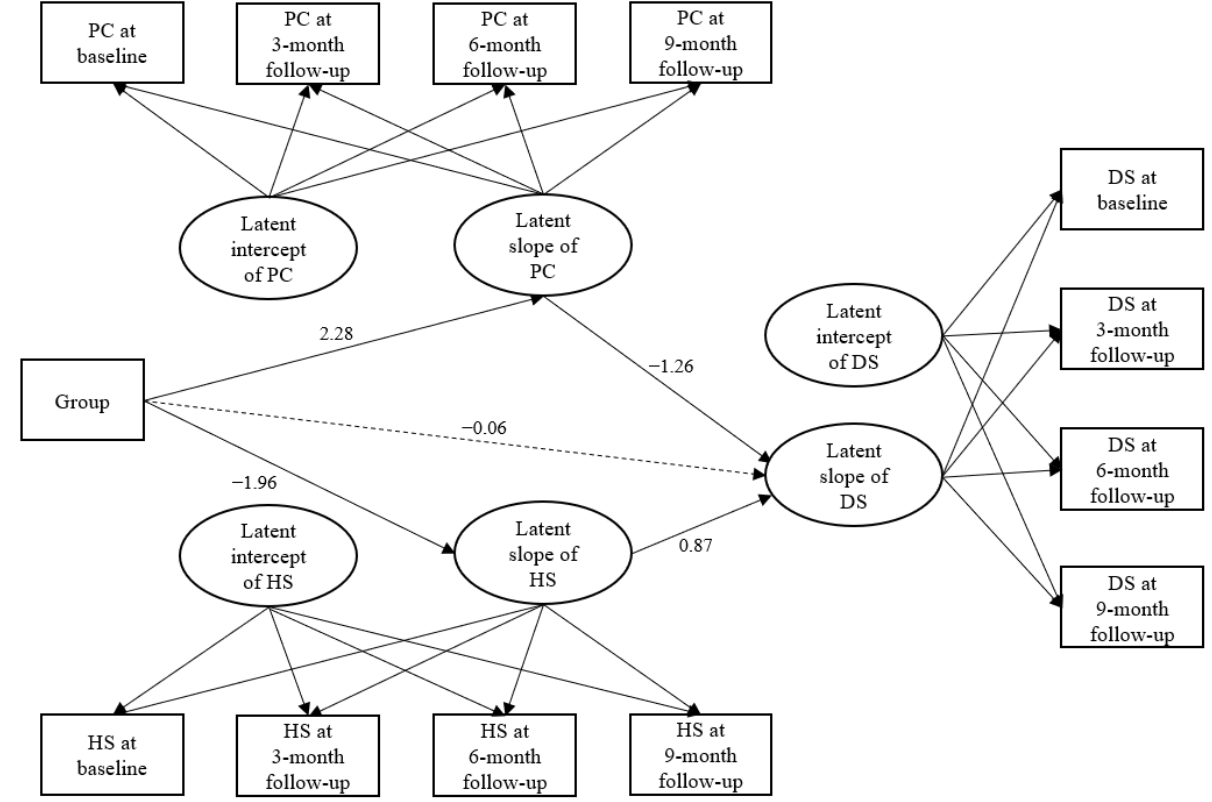
Figure 3. Latent growth curve modeling examining mediating effects between the mobile health intervention and changes in depressive symptoms. Continuous lines with arrows indicate statistically significant paths. Dotted lines indicate nonsignificant paths. The first and second factor loadings of the latent slope of the model were set to 1, the third and fourth factor loadings of the latent slope of the model were freely estimated. Group: intervention or control group; PC: positive coping; HS: HIV-related stigma; DS: depressive